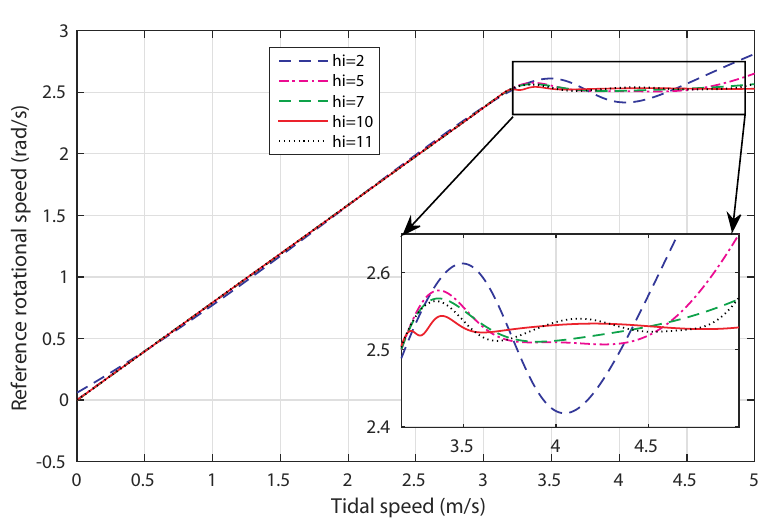
Figure 7. Performances of the multi-layer ANN training.